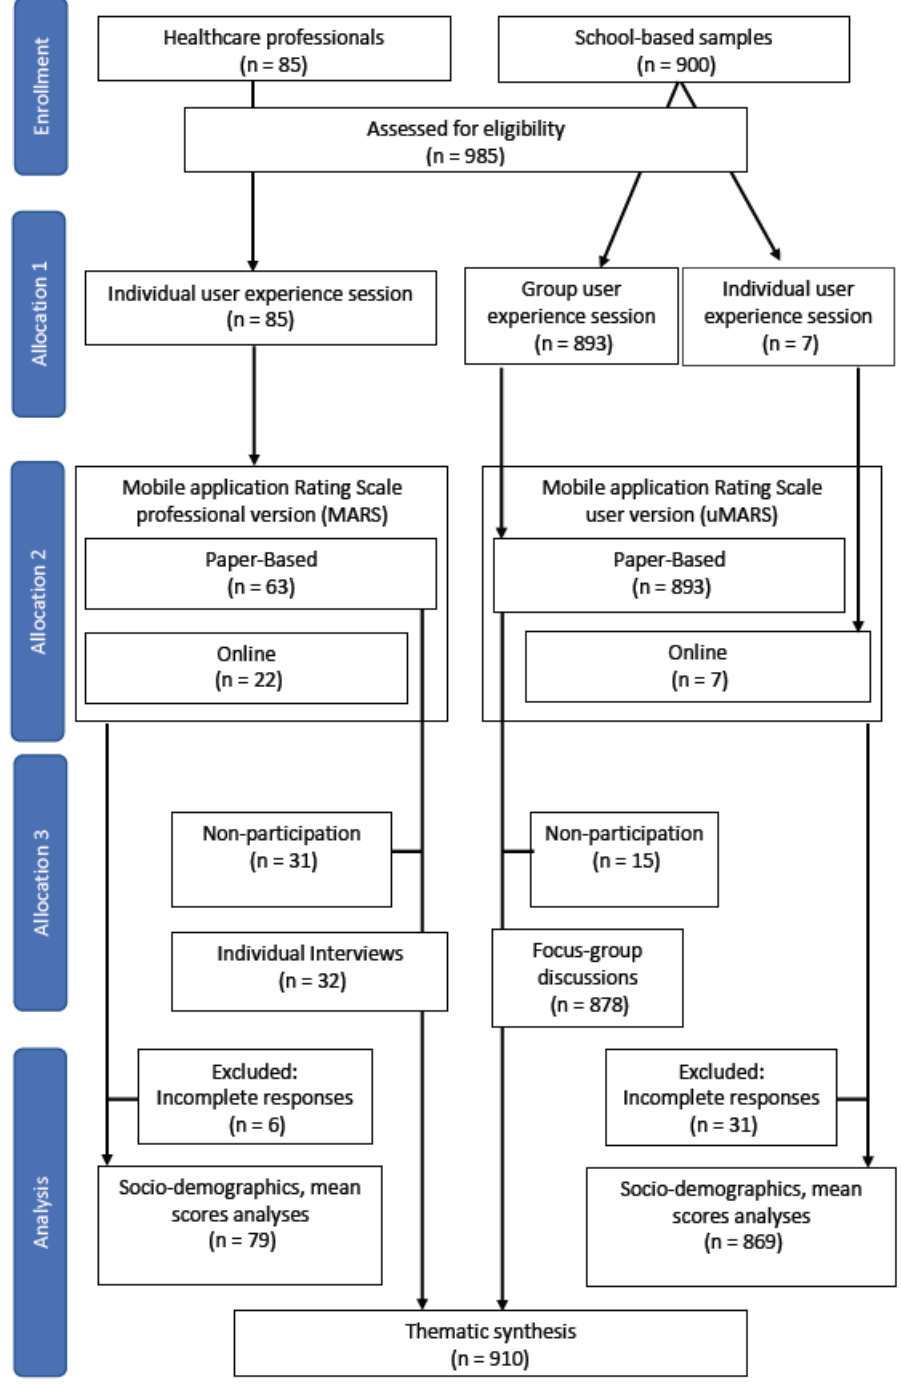
Figure 3. Consolidated Standards of Reporting Trials diagram of participant flow from enrollment, allocation, and